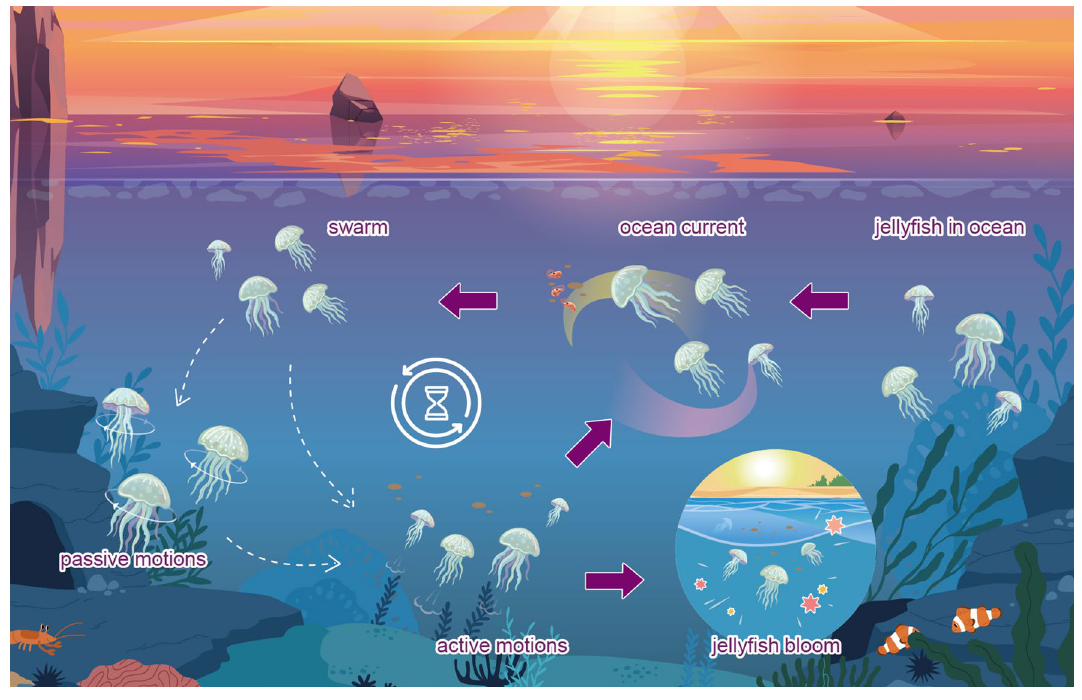
Figure 1. Search behavior and movement of jellyfish in